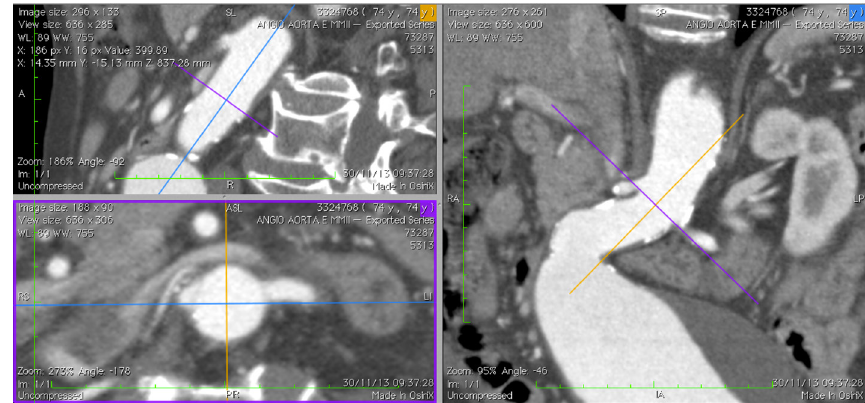
Fig. 1 - Multiplanar reconstruction (MPR), with repair of sagittal and coronal projections and axial cut at right angles (below